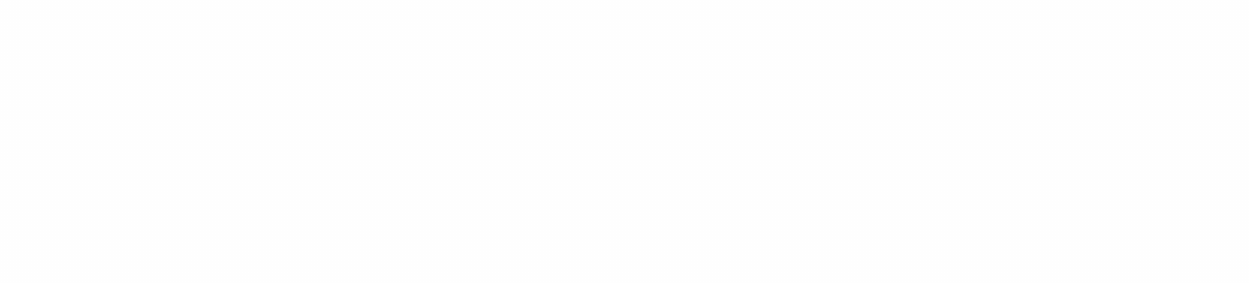
FIGURE The murine RAG locus, illustrating the intergenic region. For RAG-1 and RAG-2, the open box reflects coding regions and the hatched boxes are the 3’ UTRs. The expanded section is the sequenced intergenic region (accession number U96151). Potential transcription binding sites are shown above the line, and shaded boxes indicate repetitive genomic features. The top portion is a restriction map of the mouse RAG locus compiled from accession numbers M29475 (RAG-I), M54796 (RAG-2), and U96151 (the intergenic region). The numbers begin with M29475 and are numbered consecutively through RAG-2. Not included in the restriction map are the two introns immediately following 3’ of the 5’ UTRs of RAG-1 and RAG-2, indicated by inverted V’s. Also shown are the locations of subclones Fragment and Fragment